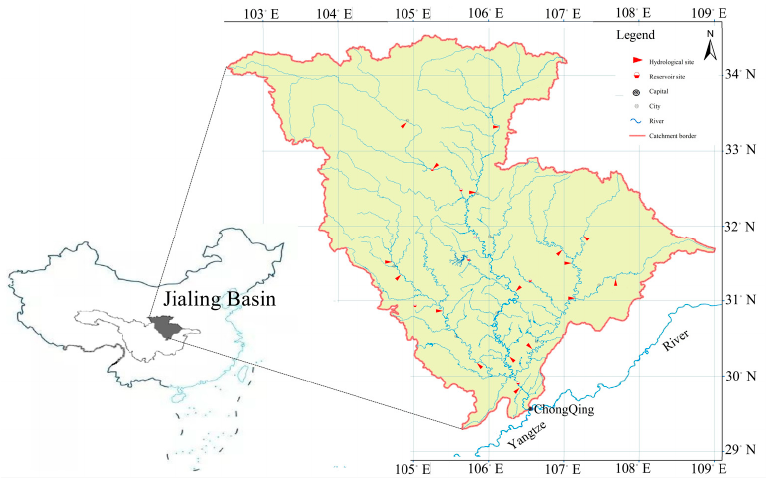
Figure 6. Location of the Jialing Basin.